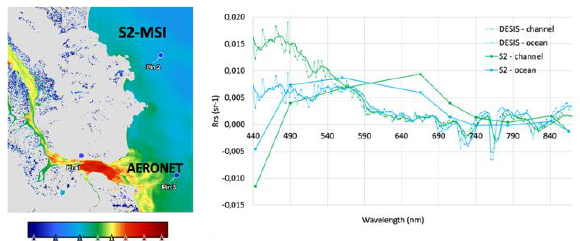
Figure 10 . Left: S2-MSI retrieved chlorophyll-a concentration (mg/m 3 ). Right: Rrs spectrum for pin 2 (ocean) and pin 1 Figure 7 . Rrs spectrum for the two stations plotted in Figure 6. (channel). Pin 3 shows the position of the AERONET-OC Solid lines represent spectra smoothed by a 5-point moving station. Solid lines represent spectra smoothed by a 5-point average. moving